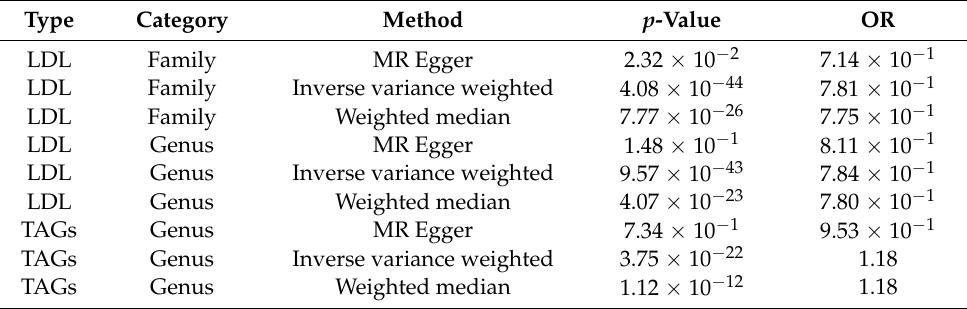
Table 6. Mendelian randomization results of Bifidobacteria and blood lipid levels.